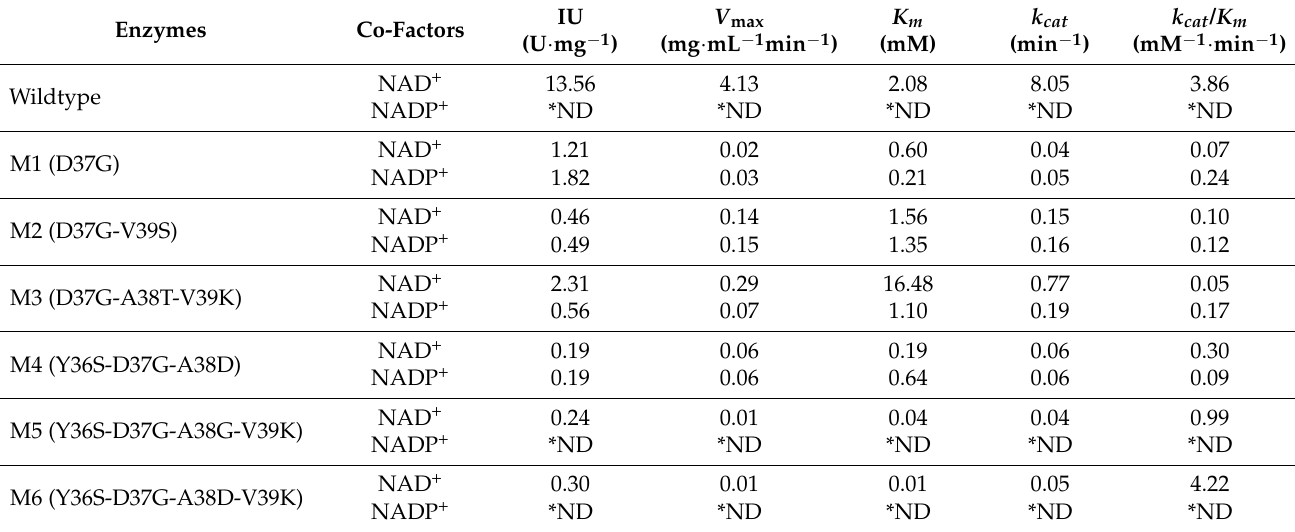
Table 1. Enzyme kinetic parameters of wild-type Ml ADH and its